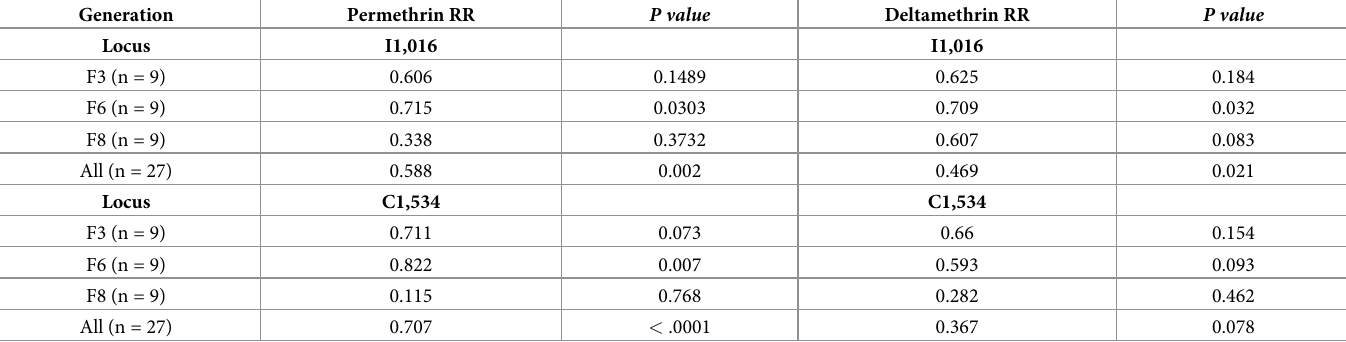
Table 7. Pearson correlation coefficients and their significance between the frequencies of I1,016 or C1,534 alleles and Resistance Ratios (RR) for permethrin or del- tamethrin as determined by bioassays for all eight collections. Generation